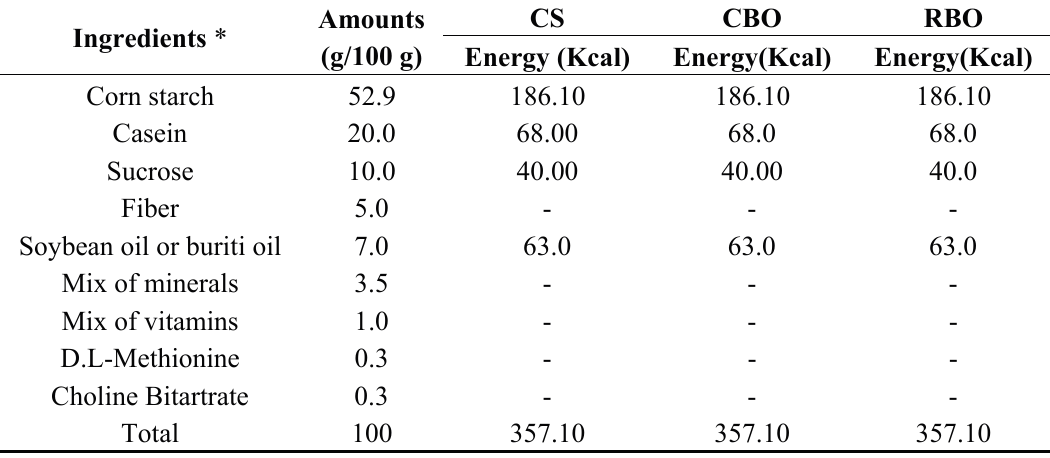
Table 5. Composition of diets of control group added of soybean oil (CG) and experimental groups added of crude (CBO) or refined buriti oil